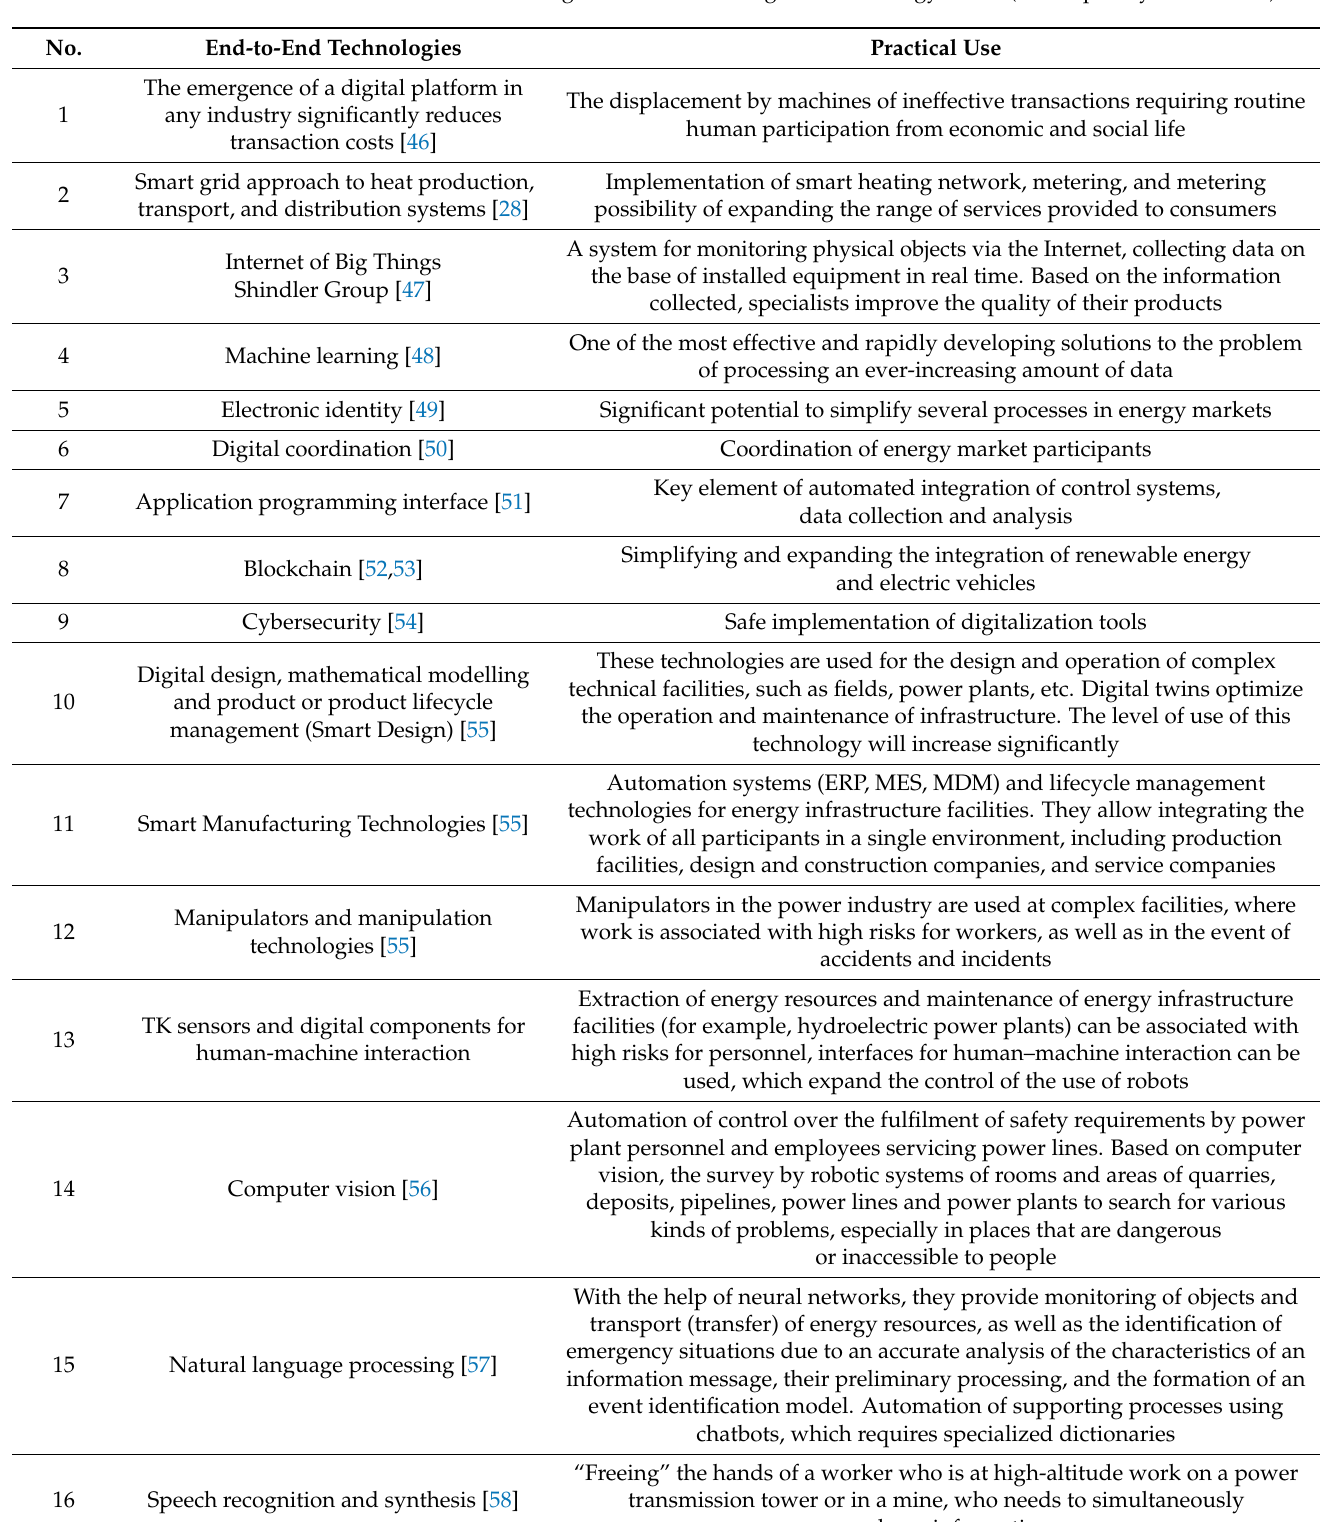
Table 4. End-to-end digitalization technologies in the energy sector (developed by the authors).